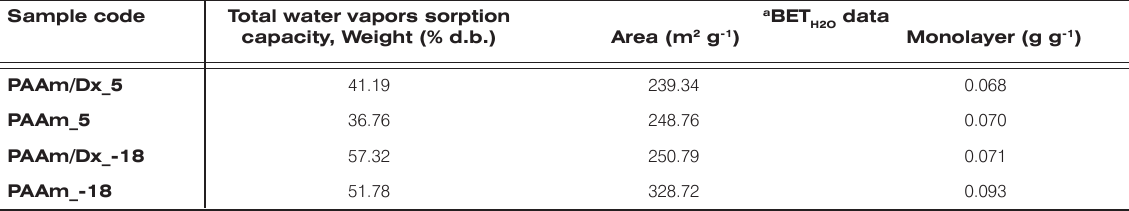
Figure 8. Sorption-desorption isotherms of the PAAm/Dx semi-IPN gels and PAAm gels prepared at 5 o C and -18 o C. Table 3. The main surface parameters evaluated based on sorption isotherms. Sample